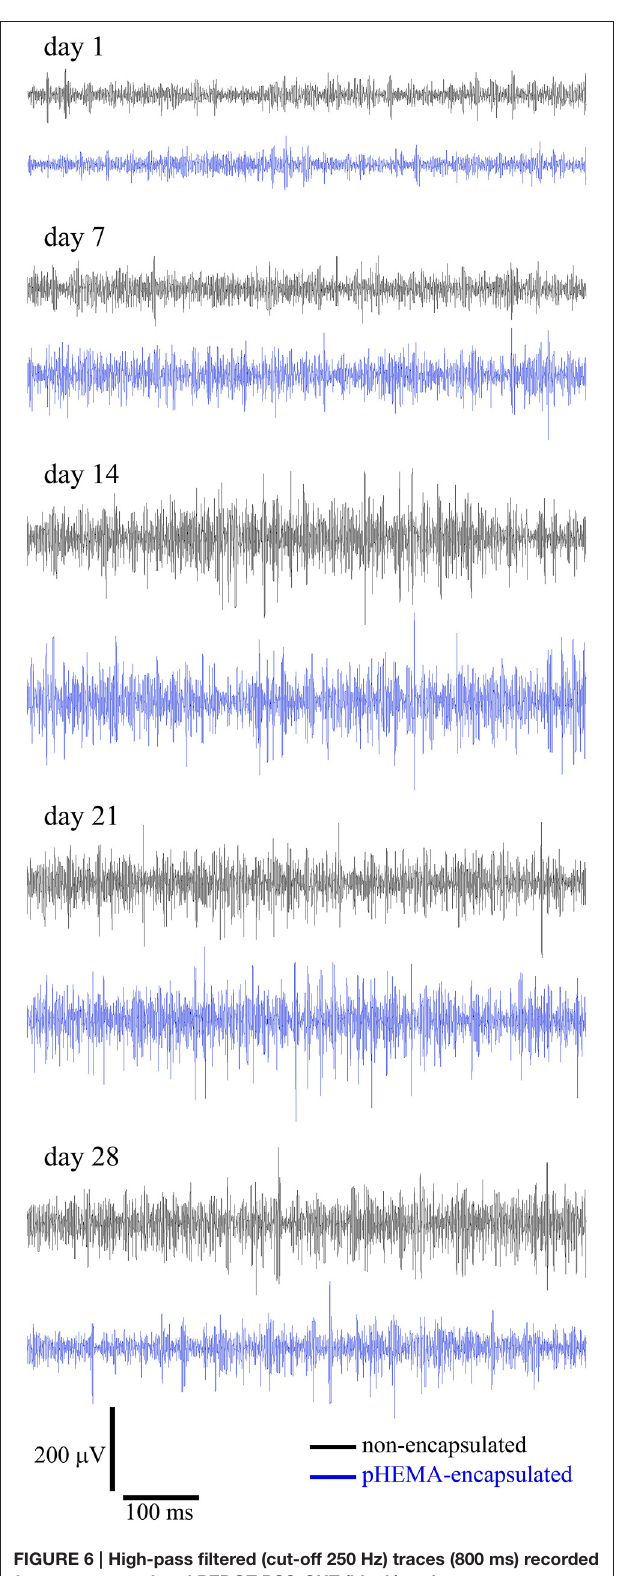
FIGURE 6 | High-pass filtered (cut-off 250 Hz) traces (800 ms) recorded for non-encapsulated PEDOT-PSS-CNT (black) and pHEMA-encapsulated (blue) microspheres at 1, 7, 14, 21, and 28 days after the implant.